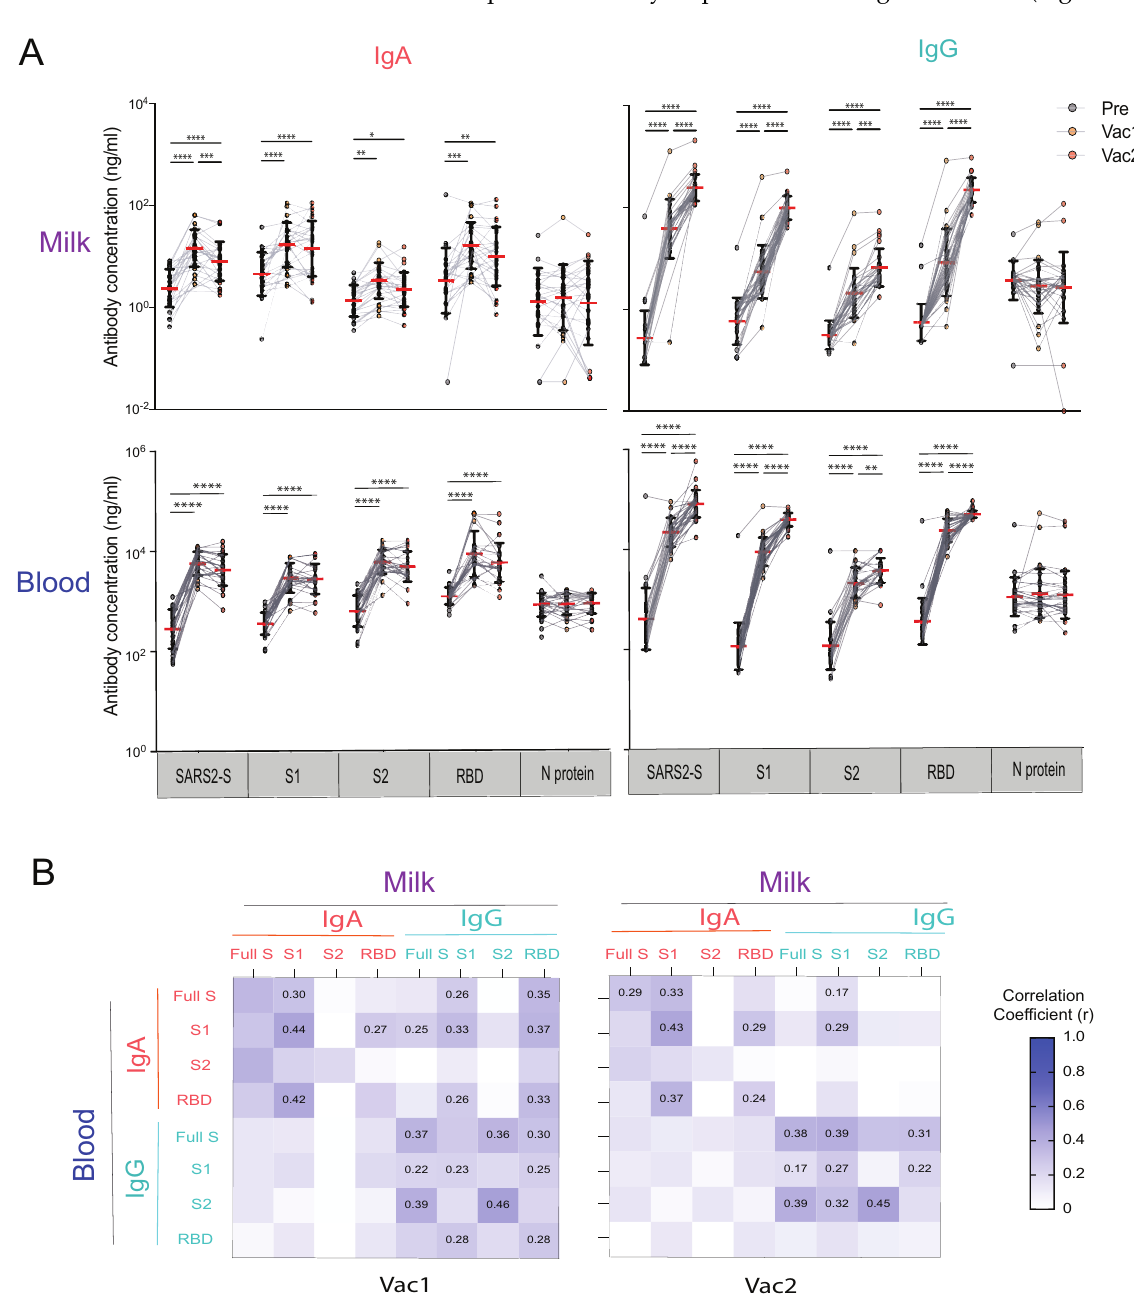
Figure 2. Human milk and blood SARS-CoV-2 specific IgA and IgG antibody response to mRNA vaccination in lactating parents. ( A ) IgA and IgG antibody responses to SARS-CoV-2 S (SARS2-S), S1, S2, RBD, and N of SARS-CoV-2 elicited by COVID-19 mRNA vaccination. The milk and fingerstick blood samples were collected pre-vaccine (PRE), 18 days after the first dose (Vac1), and 18 days after the second dose (Vac2). Antibody concentrations were estimated using the mPLEX-CoV assay (see Methods ). Generalized linear mixed-effects models were used to test for differences between time points (**** p < 0.0001, *** p < 0.001, ** p < 0.01, * p < 0.05). ( B ) Heatmap of the Spearman correlations between IgA and IgG concentrations against SARS2-S, S1, S2, and RBD in milk and blood. Correlation coefficients (r) are color coded as shown in the figure and numerical values are given when the correlation p-value are less than